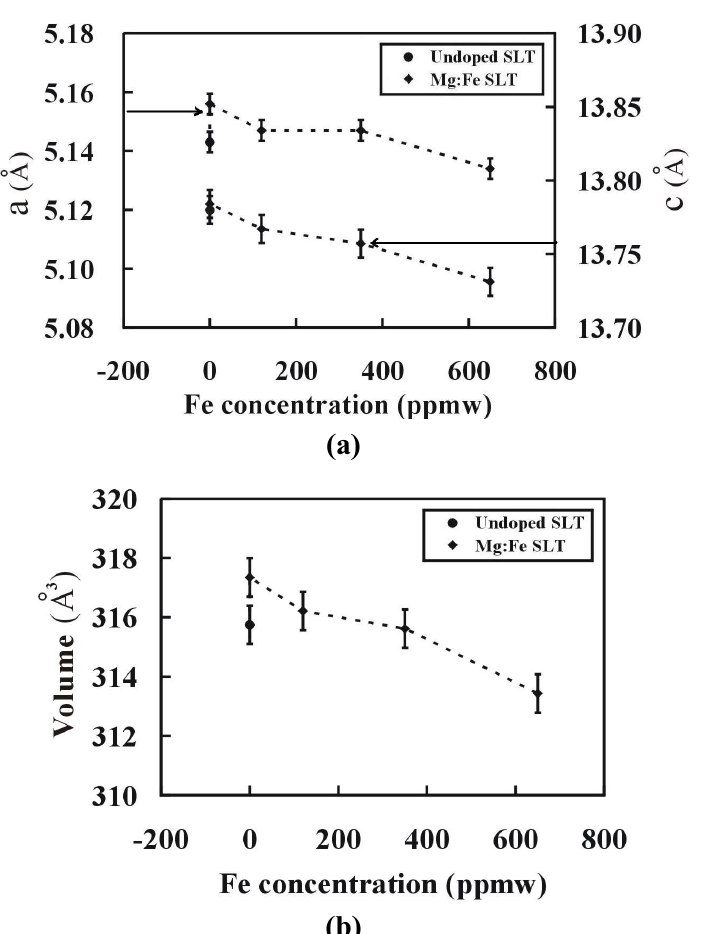
Figure 5. Variation of ( a ) lattice constants and ( b ) volume of the unit cell with the increasing Fe concentration in the